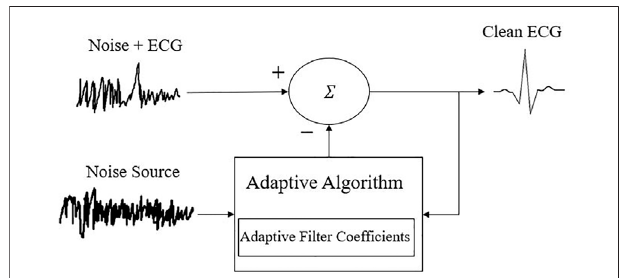
FIGURE 1 | Adaptive fi ltering for ECG noise